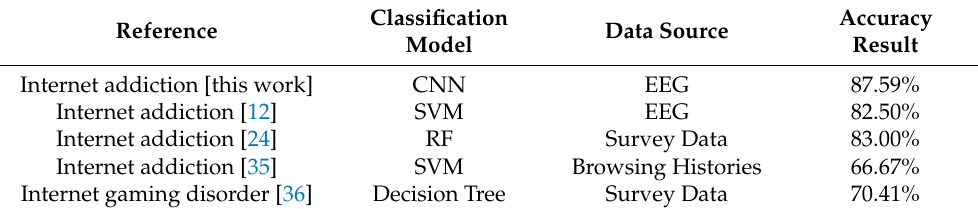
Table 2. Comparison with other state-of-the-art